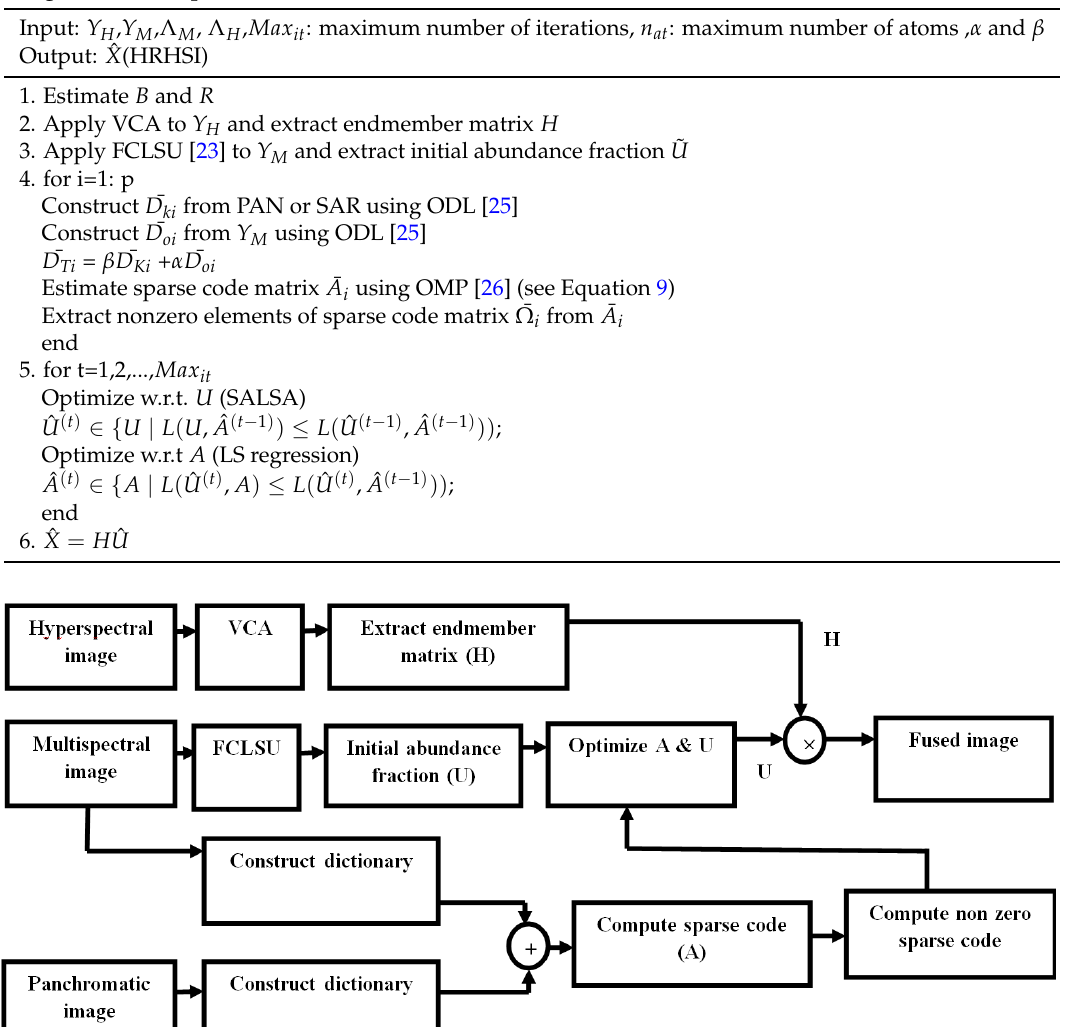
Algorithm 1: Proposed Method (SUBS)